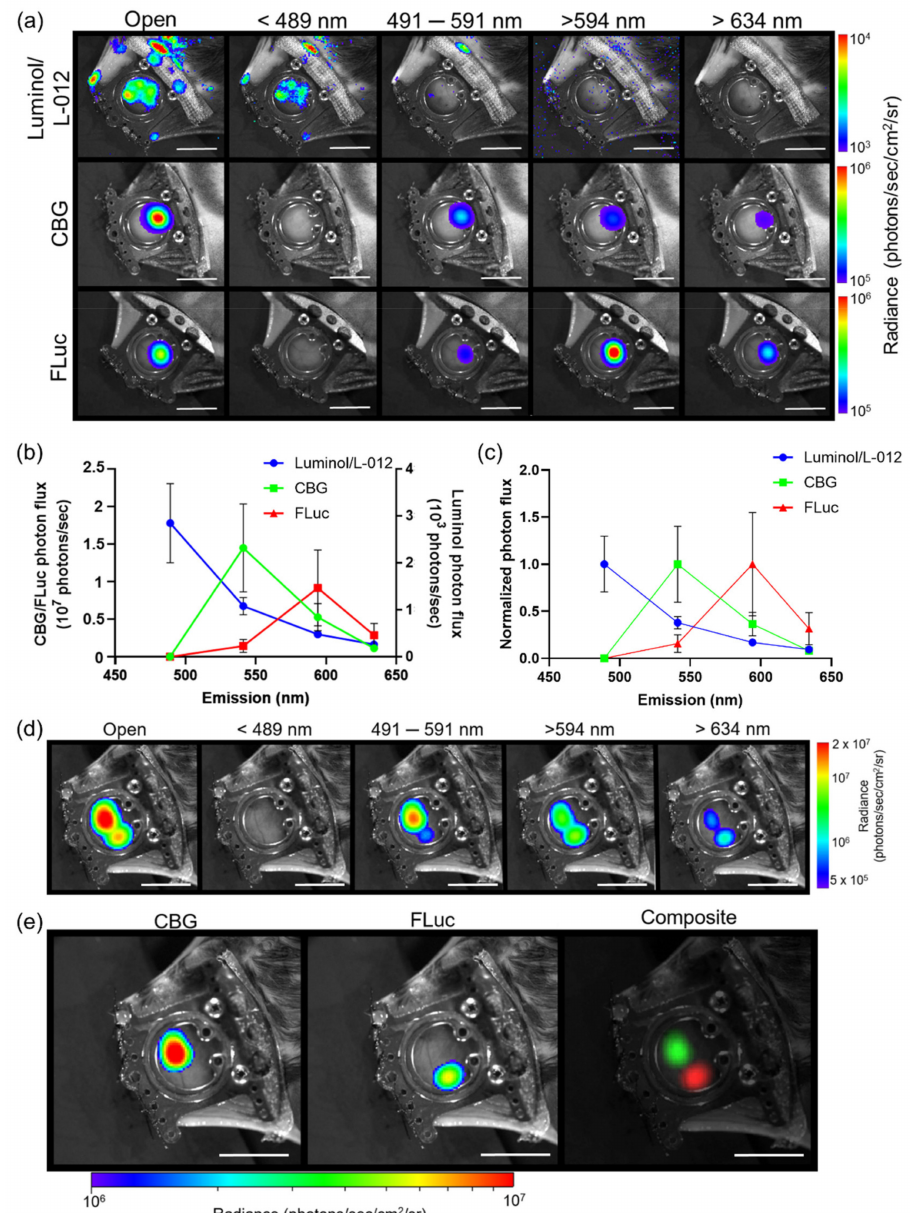
Figure 1. Generation and validation of pure in vivo bioluminescence spectra for spectral unmixing. ( a ) Representative intravital macro-bioluminescence image of separate window chamber-bearing animals for luminol, click beetle green (CBG), and firefly luciferase (FLuc) using different filter settings. ( b ) Mean and ( c ) normalized in vivo emission spectra for different bioluminescent reporters ( n = 3 animals imaged with luminol, n = 6 animals imaged with CBG, n = 6 animals imaged with FLuc). In vivo bioluminescence unmixing of B16F10 tumors; one B16F10 tumor stably expressed ubiquitin-CBG (B16F10 CBG) and the other B16F10 tumor stably expressed CMV-FLuc (B16F10 FLuc). ( d ) Representative in vivo bioluminescence image of B16F10 CBG and B16F10 FLuc tumors in the same animal within the same window chamber following a single i.p. injection of D-luciferin using all emission filters. ( e ) Representative unmixed BLI images of B16F10 CBG and B16F10 FLuc tumors in the same window following a single i.p. injection of D-luciferin; two tumors were spectrally unmixed using the CBG FLuc user-generated library. The composite image shows pseudo-colored B16F10 CBG (green) and B16F10 FLuc (red) tumors within the same window chamber ( n = 2 animals). Scale bar represents 1